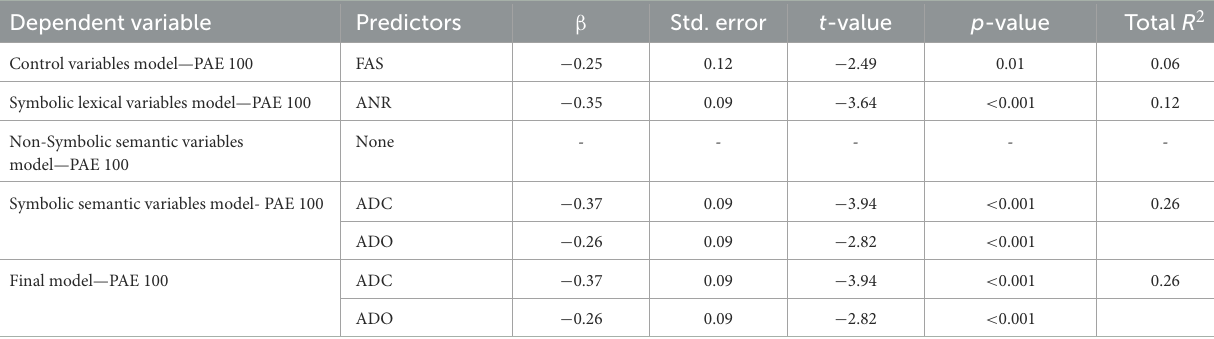
TABLE 4 Best fit models for each group of